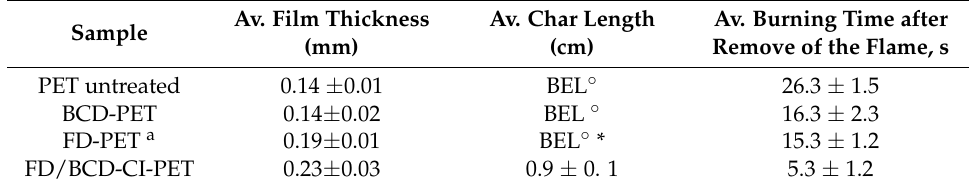
Table 2. Fire retardance performances according to a modified American Association of Textile Chemists and Colorists (AATCC) Test Method 34 for PET films and PET film with 10% of various FR additives. (data adapted from reference 48, average of three tests).